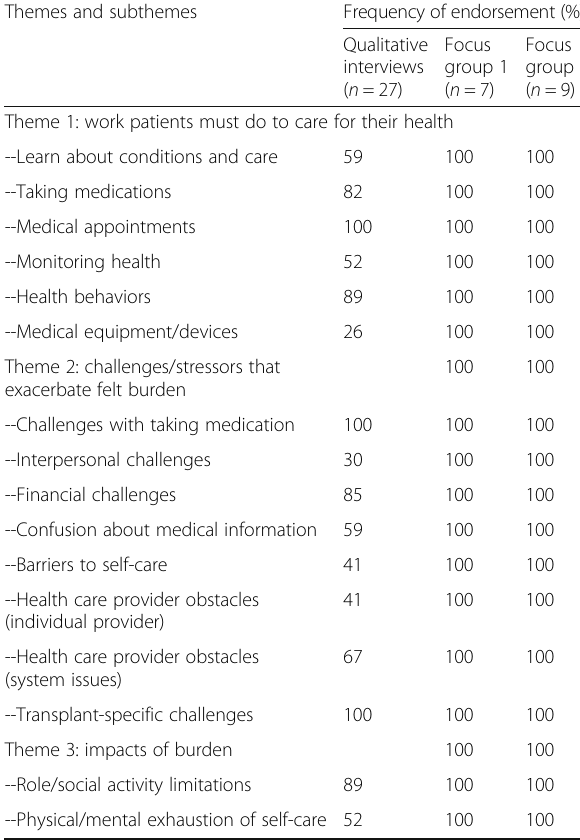
Table 2 Saturation grid of themes and subthemes represented in qualitative interviews and focus groups Themes and subthemes